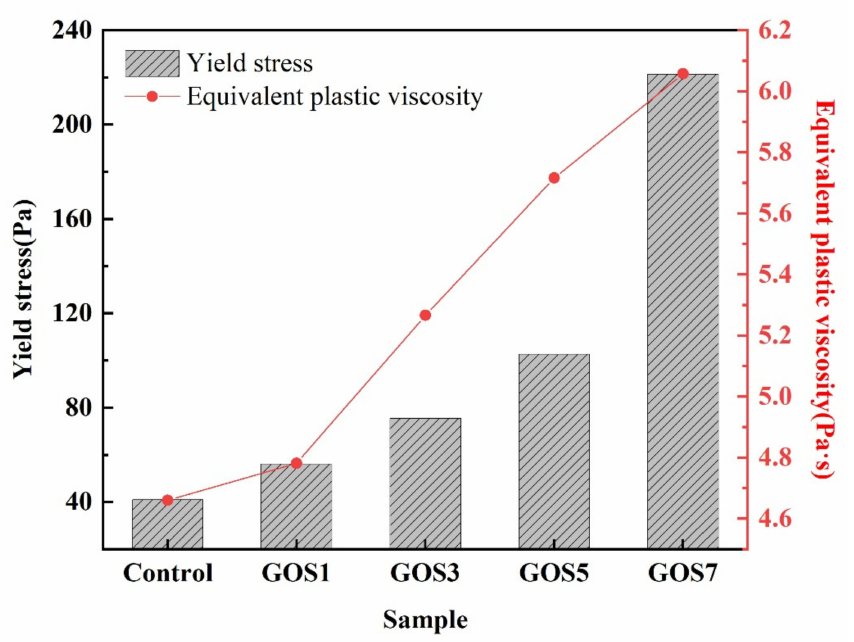
Figure 8. The effects of yield stress and equivalent plastic viscosity of fresh cement paste with different GOS